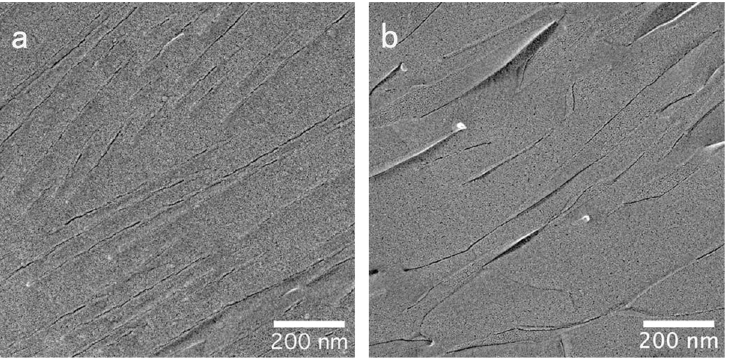
Figure 4. Typical images of 9-2-2-6 ( a ), and 11-2-2-6 ( b ) solutions observed by freeze-fracture TEM.